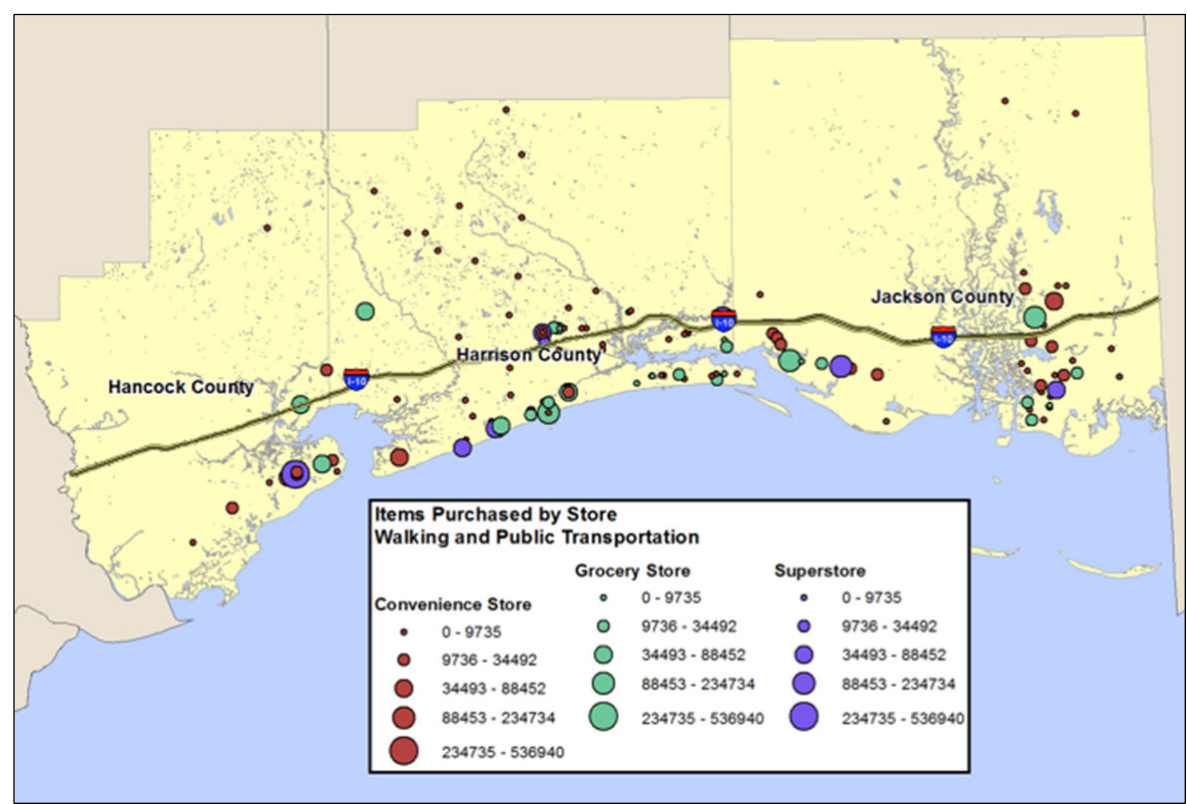
Figure 10. Map of the stores and their estimated frequency of usage (number of items purchased per store) by residents in the Gulf Coast counties of Mississippi, if they were to purchase all items in the USDA Thrifty Food Plan during spring 2011 at the lowest cost, including both the costs of the food items and transportation by a combination of walking and public transportation by bus to acquire